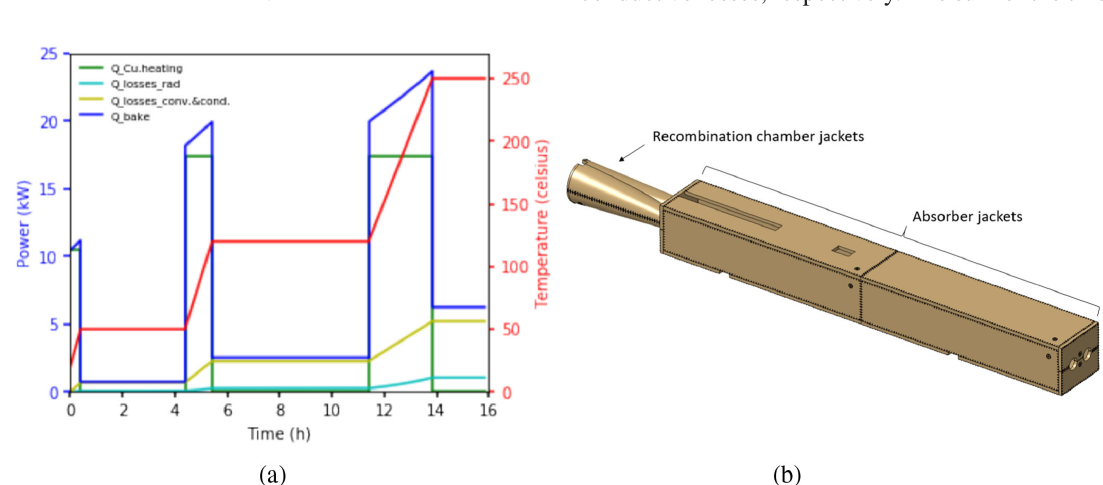
FIG. 8. Bakeout. (a) Power supply during the bake-out cycle on the absorber jackets. (b) Bake-out jacket